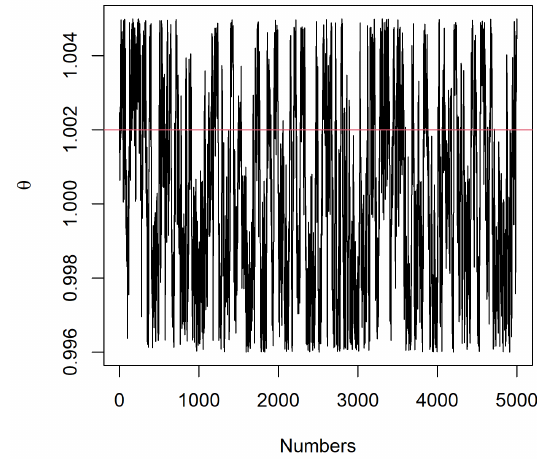
Figure 5. The Markov chains of θ .